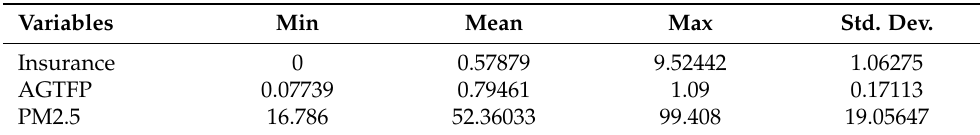
Table 1. Descriptive statistics.